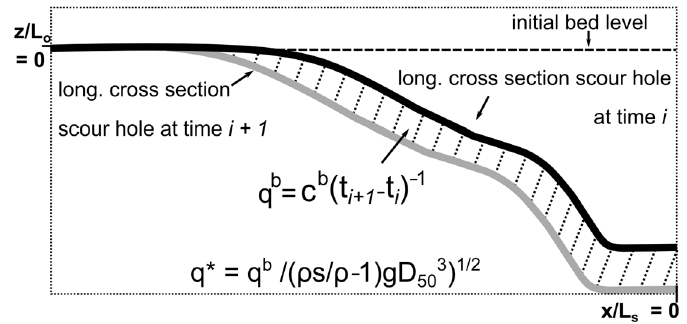
Figure 11. Estimation of bedload transported out of the local scour hole along its longitudinal axis (l s -d s , Figure 1c).